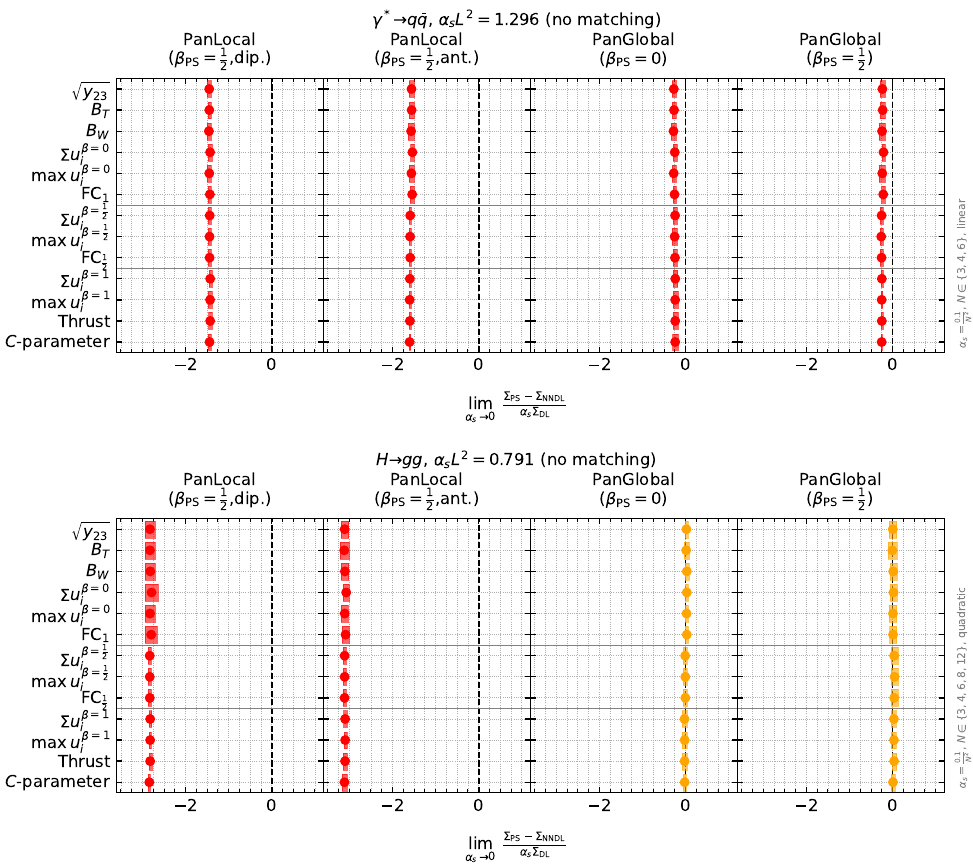
Figure 3. Results of the NNDL accuracy tests at fixed ξ = α s L 2 for the PanLocal dipole and antenna (with β = 1 ) and PanGlobal ( β = 0 and β = 1 ) showers, without 3-jet matching, for ps ps ps 2 2 γ ∗ → q ¯ q (top) and H → gg (bottom). In these and subsequent plots, points marked green (red) show agreement (disagreement) with the NNDL results at the 2 σ -level. Amber points manifest coincidental agreement for n = 5 as explained in the text. The plots of this figure have no green f